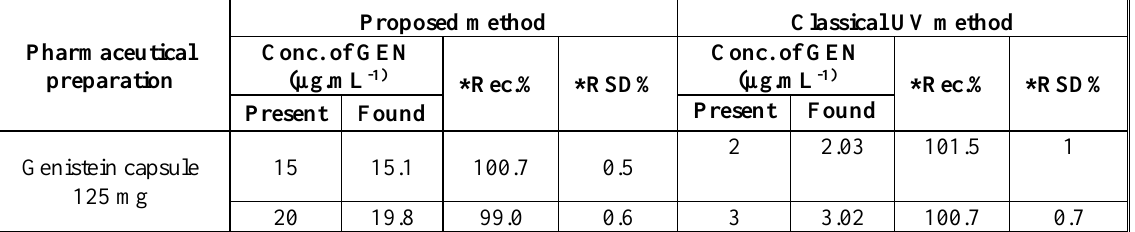
Table 6. Application of the proposed method for determining GEN in pharmaceutical formulations by using standard addition method